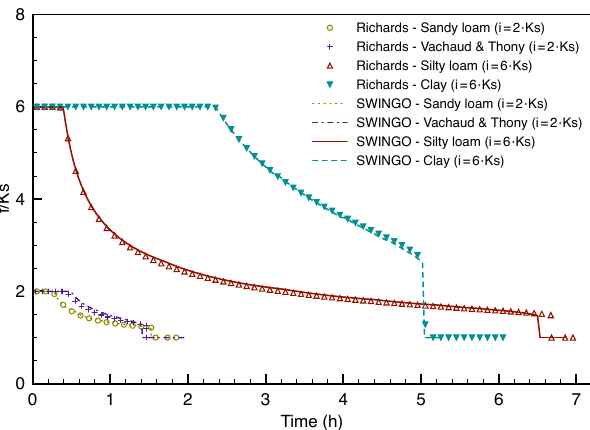
Figure 3. Comparison of normalized infiltration rates ( f/K s ) for soils without initial ponding described in Table 1, with vertical drainage (Vachaud) bottom boundary ( f w ) conditions. Lines rep- resent the SWINGO simplified model results. Symbols represents Richards equation numerical solution. The rainfall rate i was se- lected based on the saturated hydraulic conductivity ( K s ) for each soil to ensure ponding at the surface.